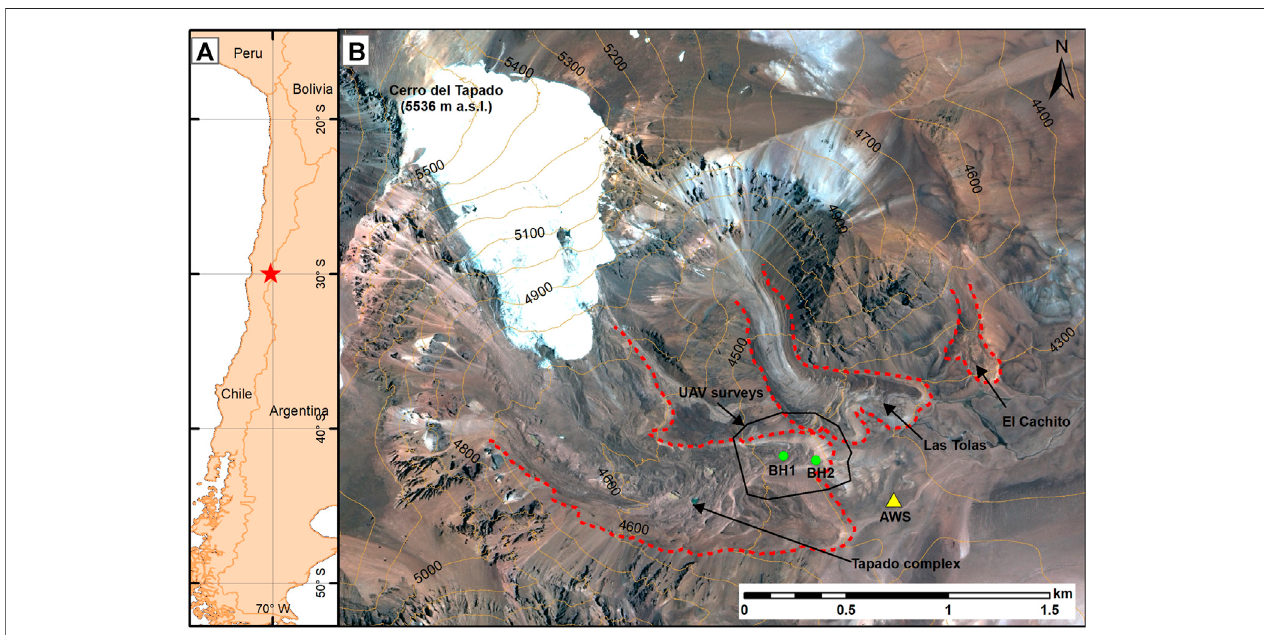
FIGURE1|(A) Locationofthe studyarea(redstar), near theboundary betweenChileand Argentina. (B) TheTapado complexand studied landforms (dashedred lines).TheyellowtriangleindicatesthepositionoftheAutomaticWeatherStation(AWS).Greencirclesindicatethepositionoftheshallowboreholes1(BH1)and2(BH2). Black polygon indicates the area covered by the UAV surveys. The background image corresponds to a Pléiades orthoimage from November 18th 2014. Contours are derived from the corresponding DEM. © CNES (2018), and Airbus DS (2018), all rights reserved.